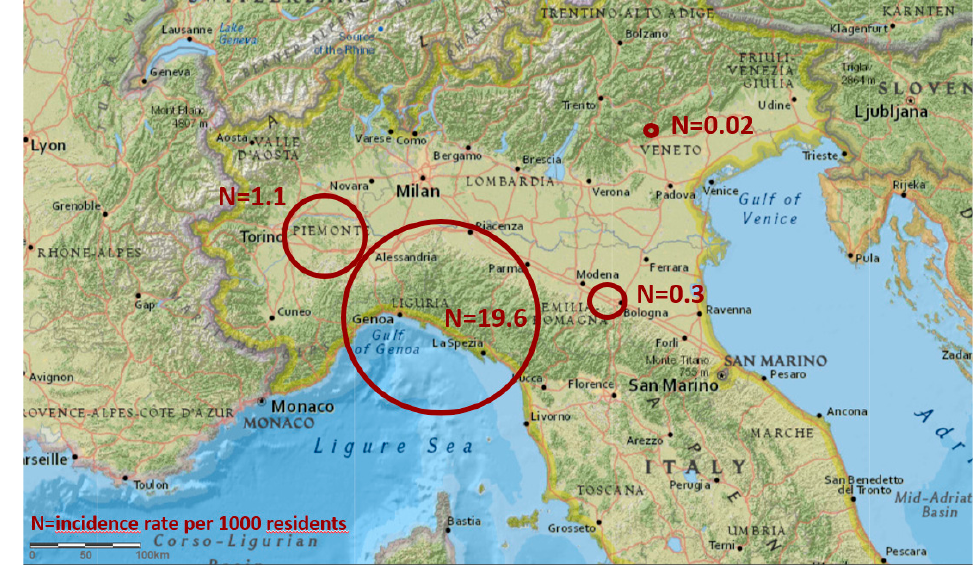
Figure 1. Map of the areas from where confirmed cases colonised with or infected by C. auris were reported, located in 4 neighbouring regions, North Italy, July 2019–December 2022 (N = 361). The size of the red circles represents the regional incidence rate per 1000 residents (N).